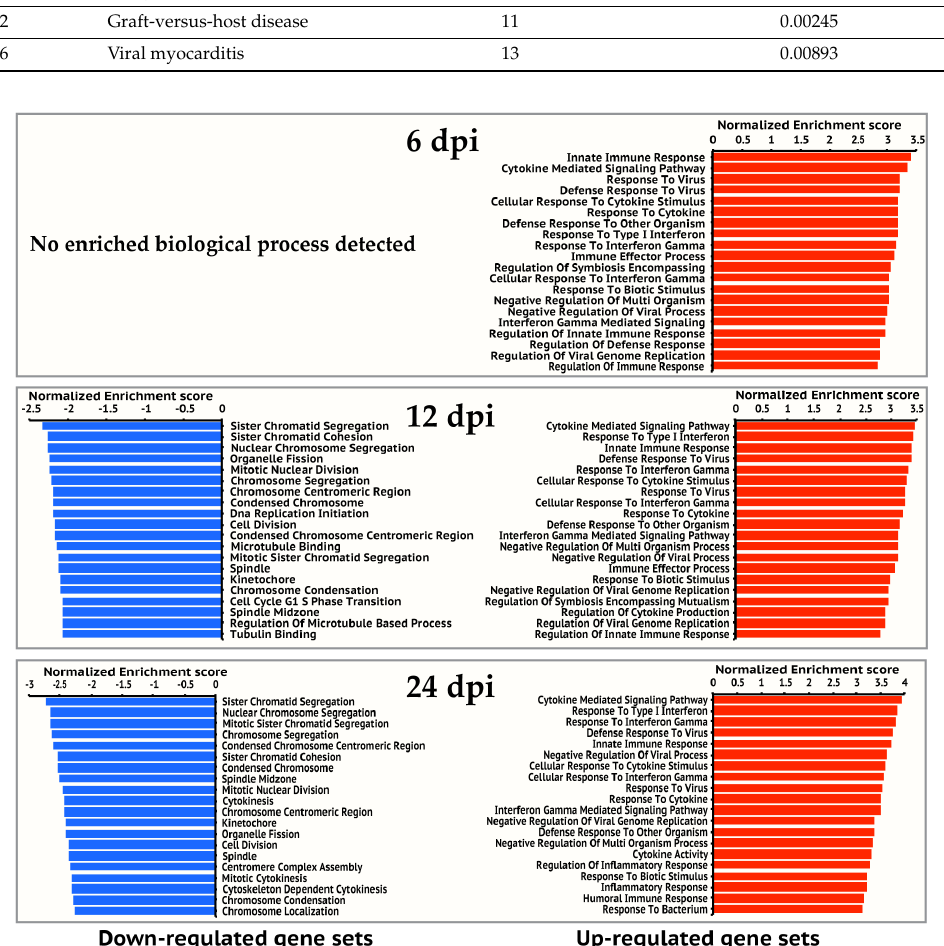
Figure 2. Top 20 enriched gene ontology biological processes for 6, 12, and 24 hpi. Gene ontology enrichment analysis was performed on up-regulated gene set and down-regulated gene set of each time point respectively on the GSEA website. The significantly enriched gene ontology processes were ranked by their enrichment scores and the top 20 processes were shown for each gene set. Blue and red panels represent down-regulated and up-regulated gene sets respectively.